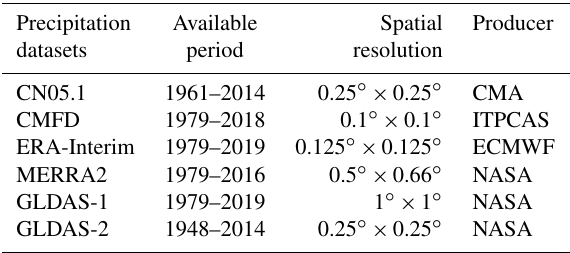
Table 1. List of six commonly used precipitation data. Precipitation